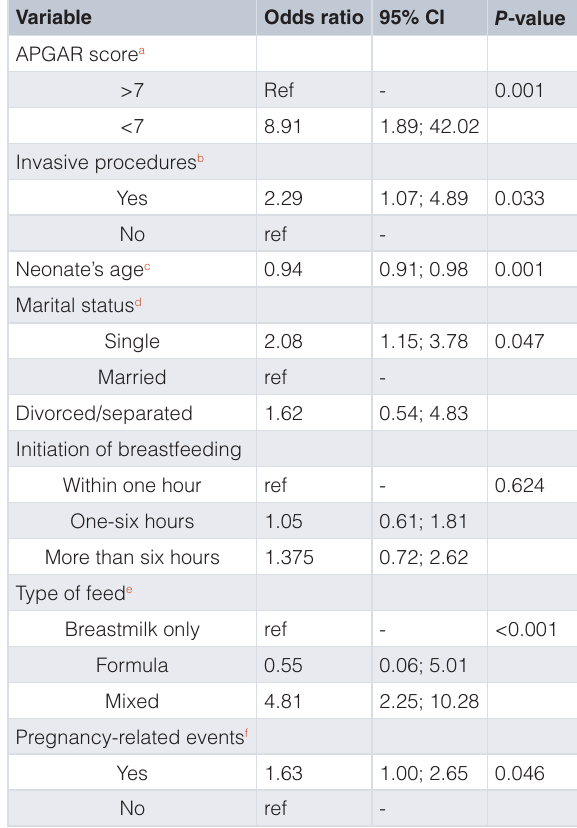
Table 5. Association between the qualifying covariates and umbilical cord hygiene among neonates at KHC, Kenya, 2018.